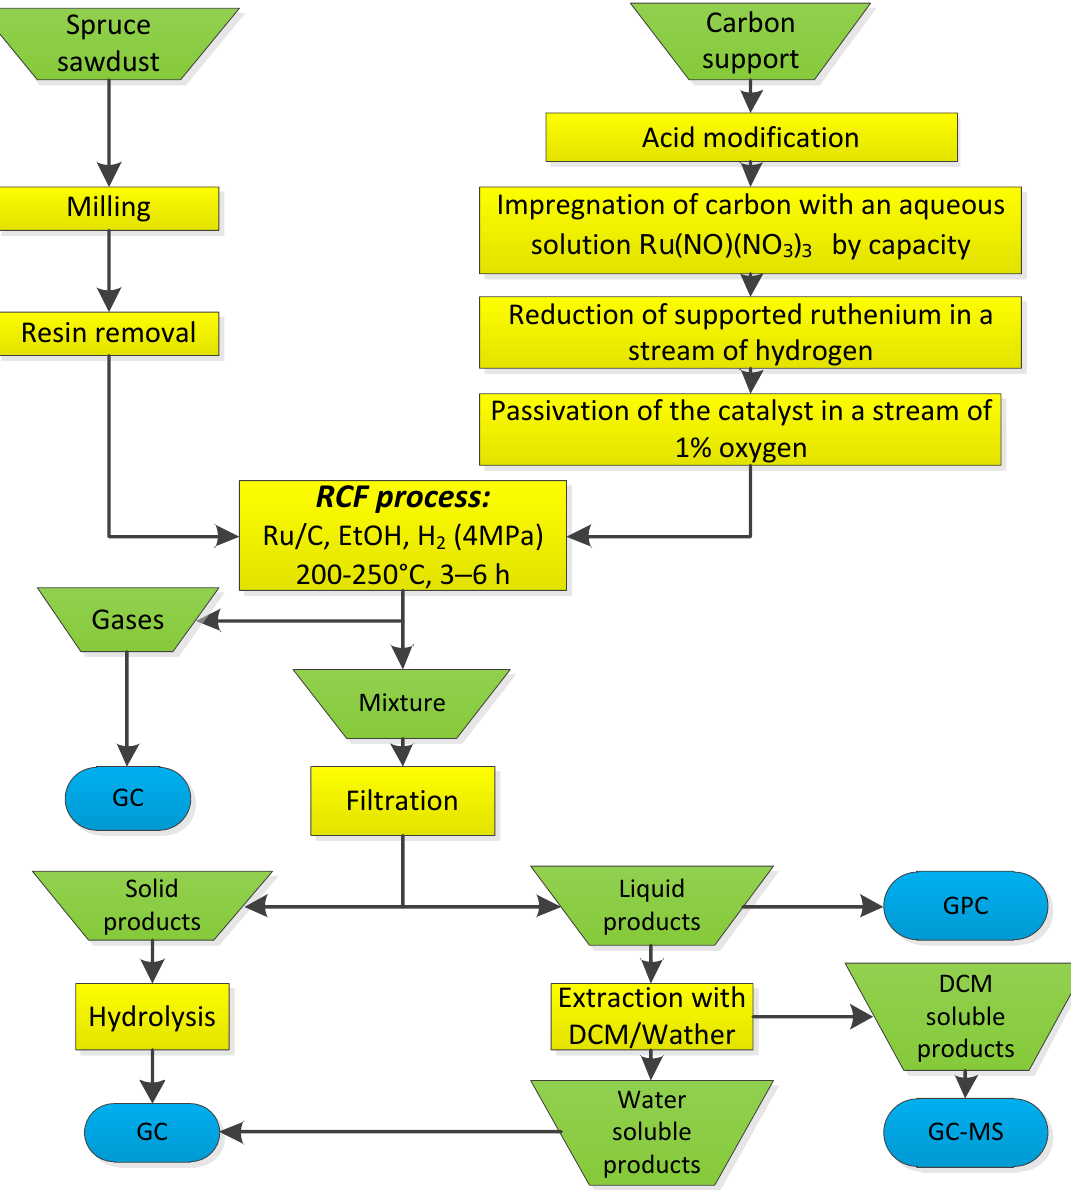
Figure 18. Overview of process flow diagram of catalytic hydrogenation of spruce wood.